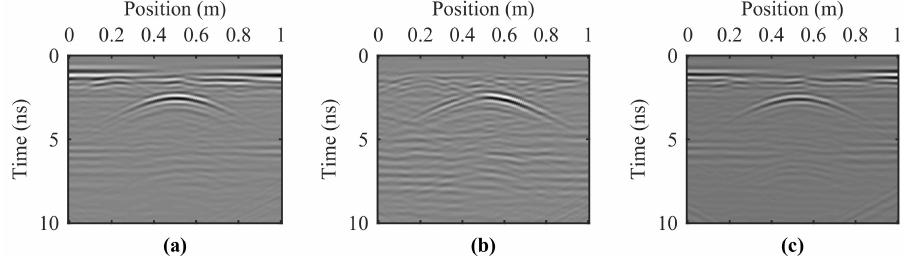
Figure 7. Full polarimetric data of metallic sphere. (a) HH polarization. (b) HV polarization. (c) VV polarization.